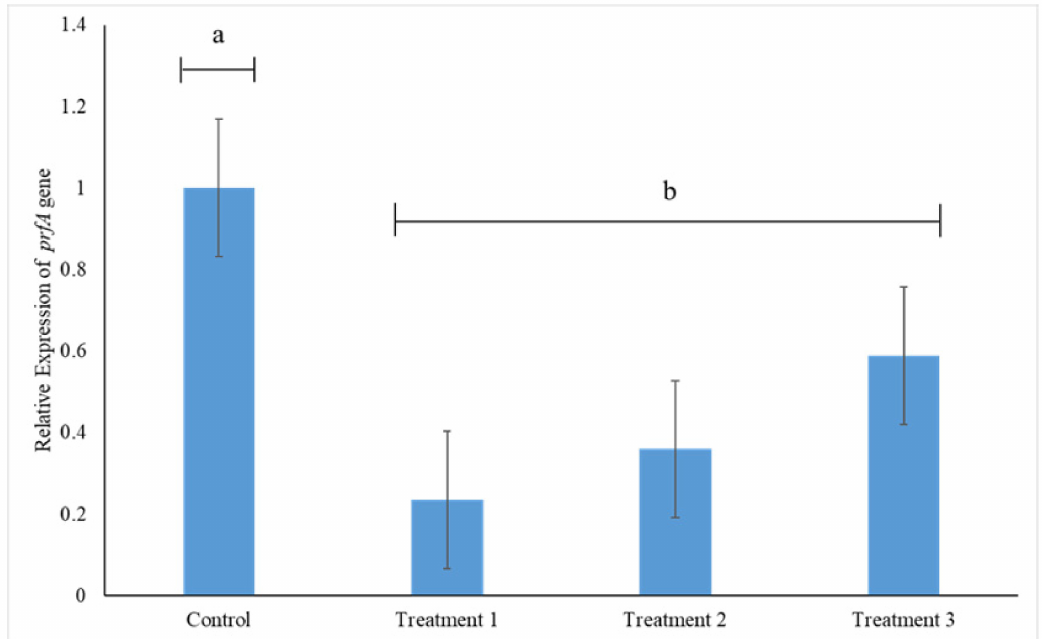
Figure 6. Relative prfA gene expression in L. monocytogenes 243 treated with cell free supernatants (CFS) of L. acidophilus La14 150B (Treatment 1), L. plantarum B411 (Treatment 2) and L. rhamnosus ATCC 53103 (Treatment 3). Bar heights indicate mean expression of the gene in triplicate samples while error bars indicate standard error. Bars with different letters are significantly different ( p <